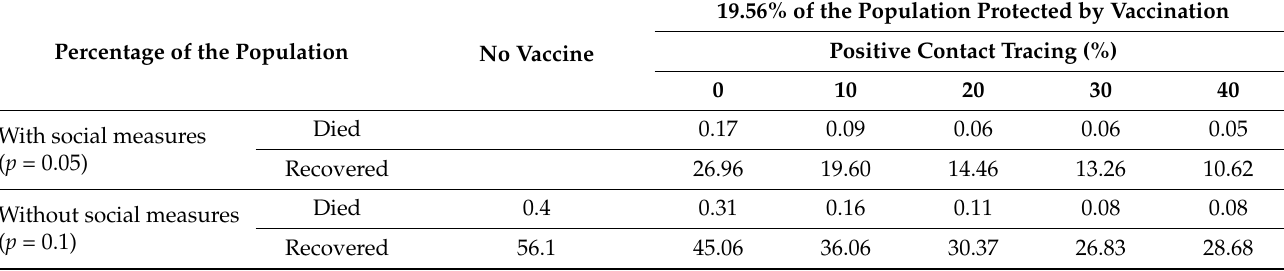
19.56% of the Population Protected by Vaccination Positive Contact Tracing (%) 0